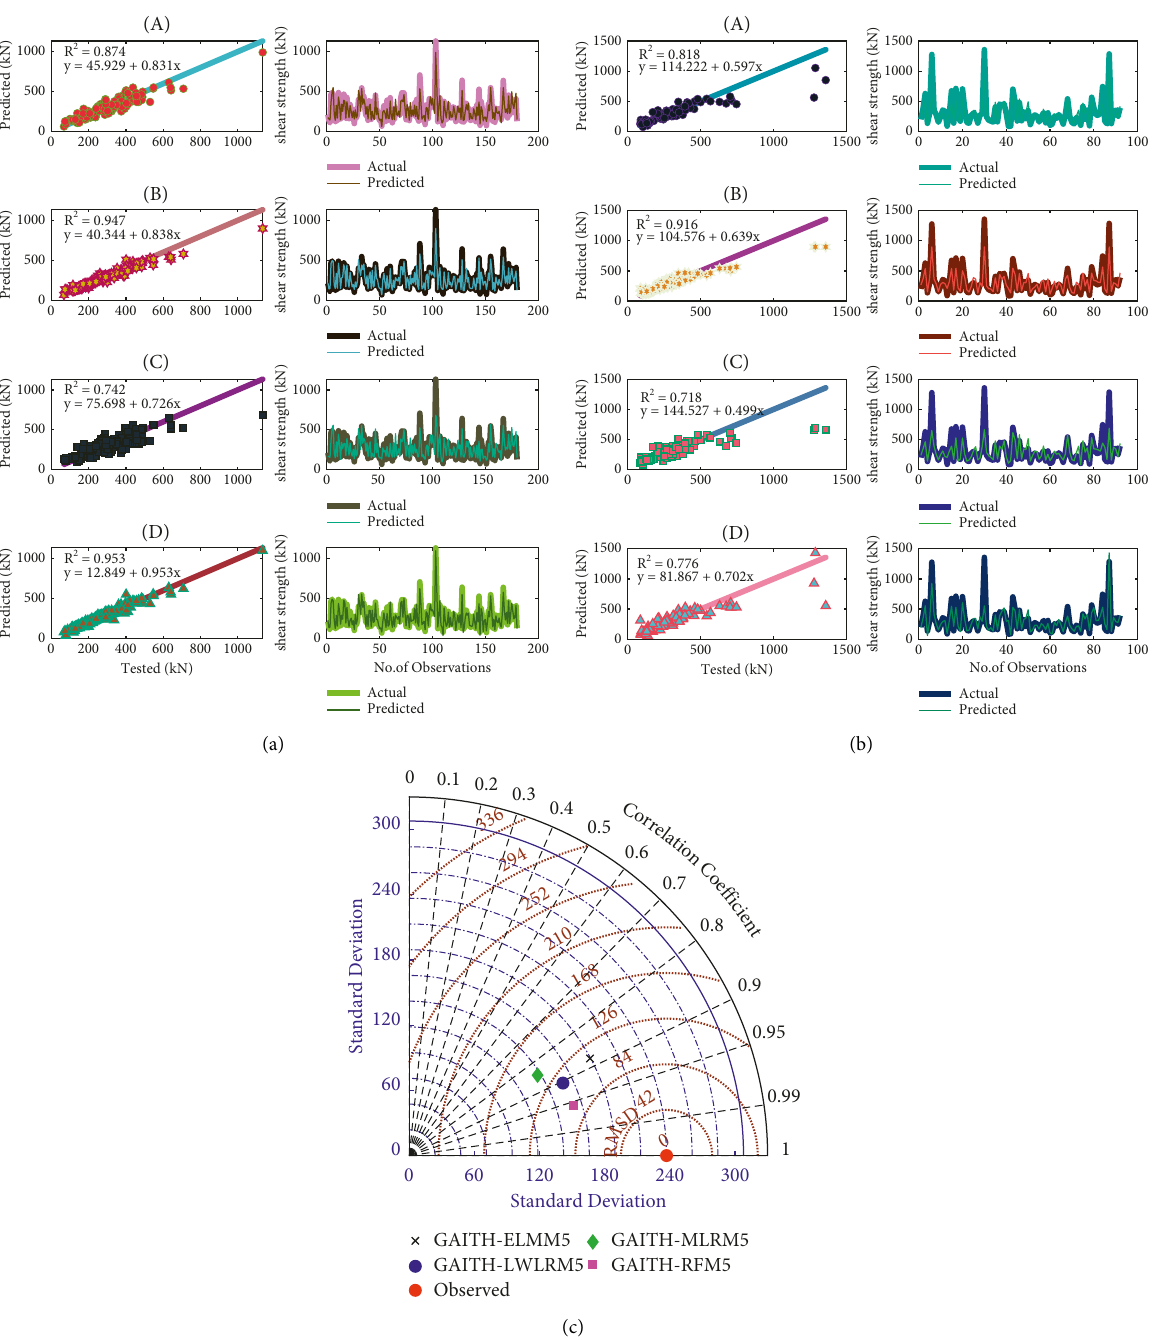
, GAITH − RF , M 4 M 4